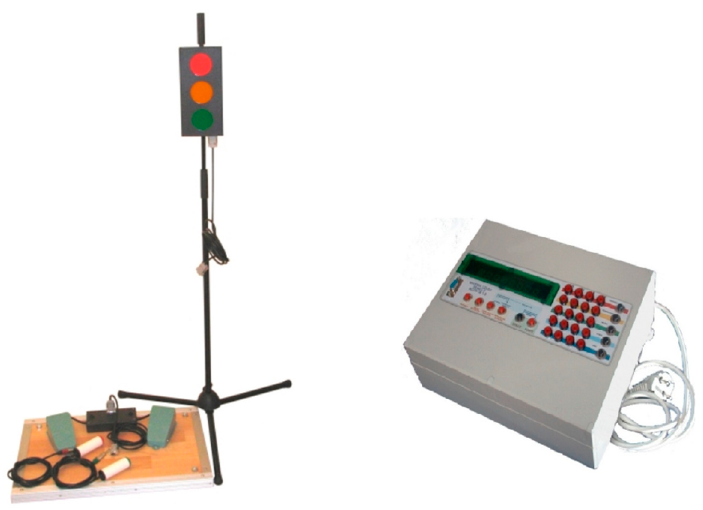
Figure 1. The MCZR/TB Response Time Meter 1.0 (ATB Info-Elektro, Ruda ´Sl ˛aska, Poland). Projector with the traffic lights and controls (push buttons and pedals) on the ( left ) and Central Unit on the ( right ).